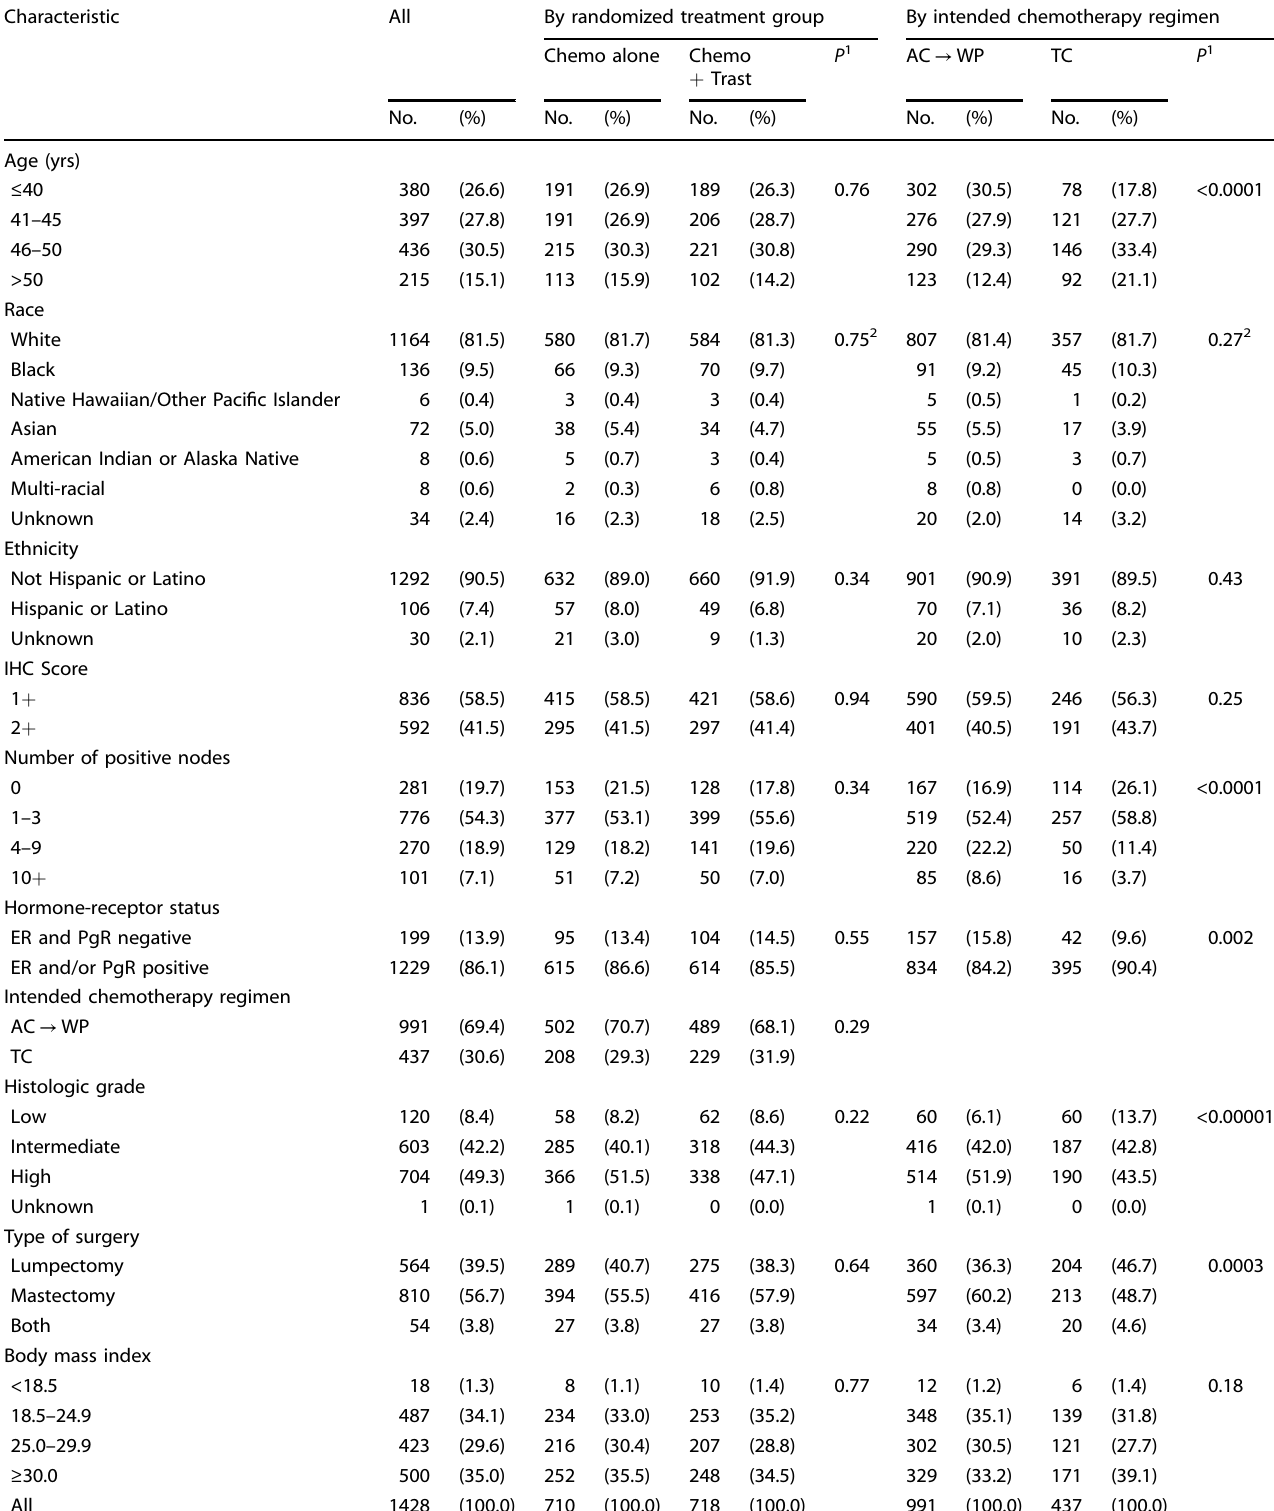
Table 1. Patient and tumor characteristics by treatment group and intended chemotherapy regimen for analyzed patients: NSABP B-47.